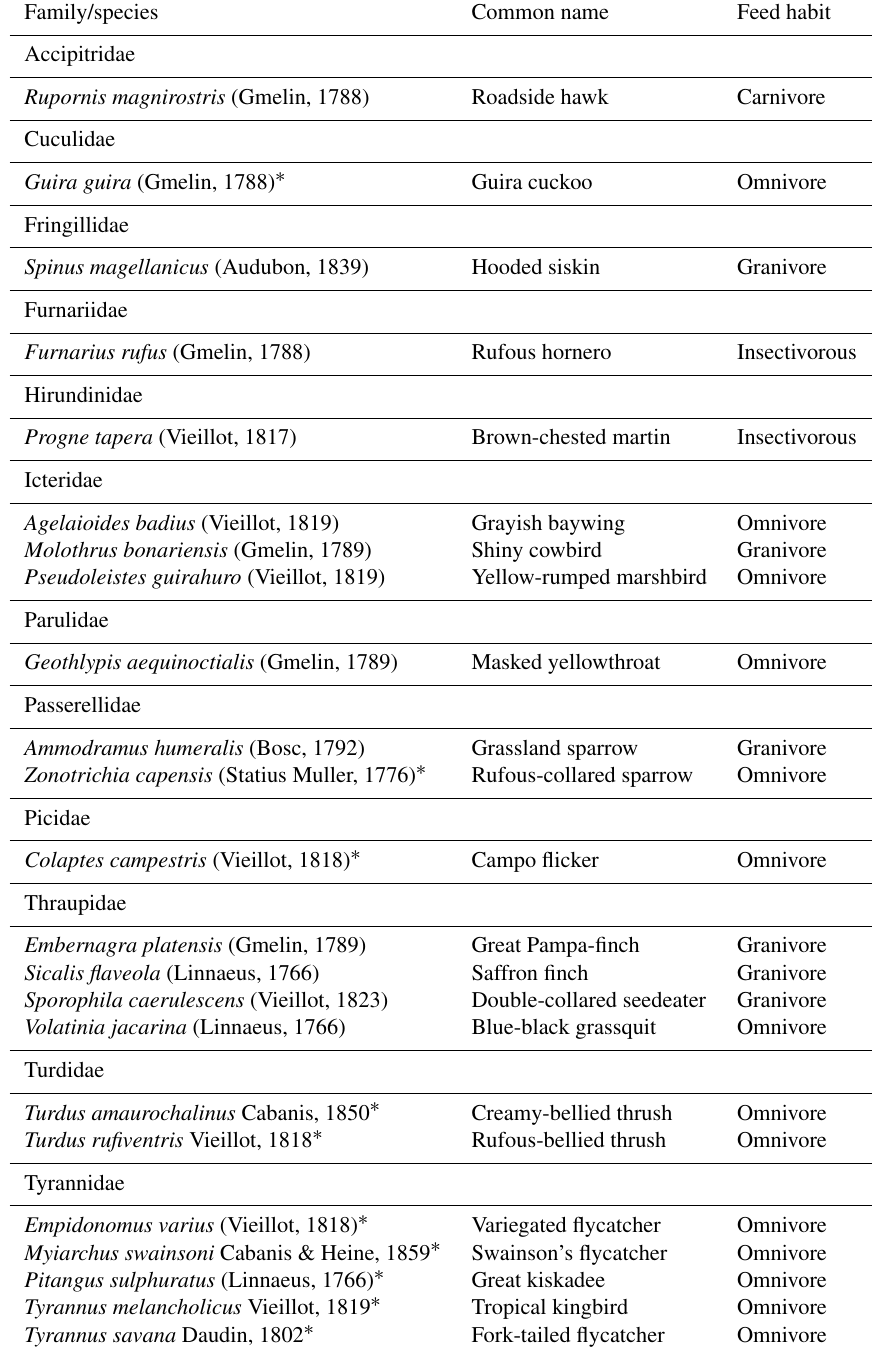
Table B1. Birdlife observed using artificial perches in southern